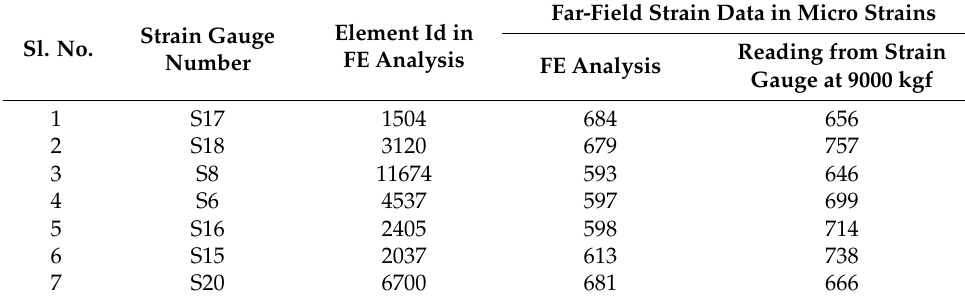
Table 2. Comparison of strains according to FE analysis and strain gages.